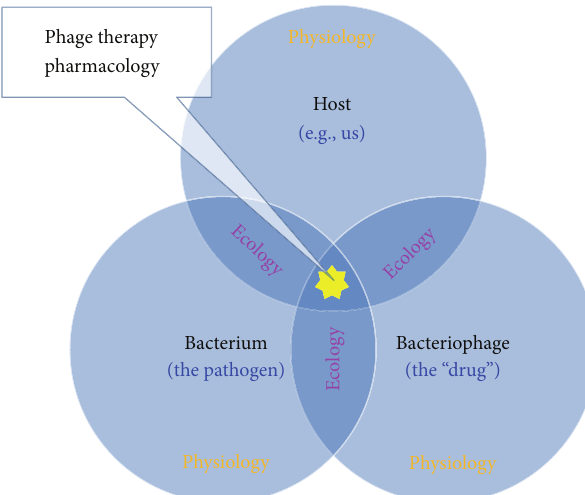
Figure 6: The interface between different organisms, and their physiologies, basically is ecological. The quantity of these interactions as well as their impact on physiologies increases with the number of organism types involved. With phage therapy, this includes three distinct species. (1) the patient, host, subject, or body that is experiencing a bacterial infection; (2) the infecting bacterial pathogen; and (3) the bacterial virus, a.k.a., phage or bacteriophage that is being used to treat the bacterial infection. Phage therapy pharmacology lies at the interface of these three components and thus inherently straddles both ecological and physiological considerations (with that confluence indicated by the star but not limited to the star). Since physiologies change with varying infection conditions as well as treatment approaches, including in terms of physiological adaptation to these changing conditions, phage therapy pharmacology can be viewed as being inherently eco-physiological.